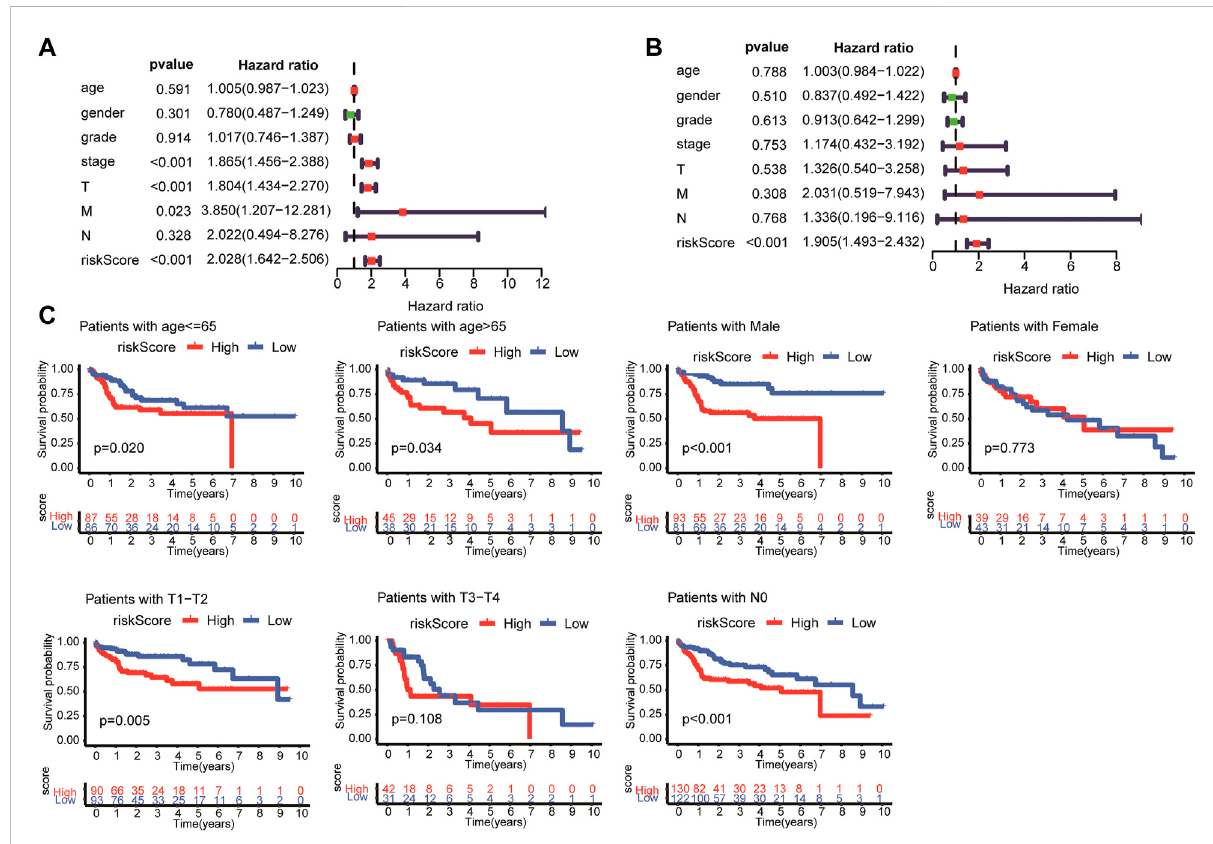
FIGURE 5 Univariate and multivariate analysis showed the risk score calculated by LASSO model was an independent prognostic predictor. Univariate (A) and multivariate (B) Cox analysis in HCC patients. (C) Subgroup Kaplan-Meier analysis of HCC patients in different age, sex, and tumor staging